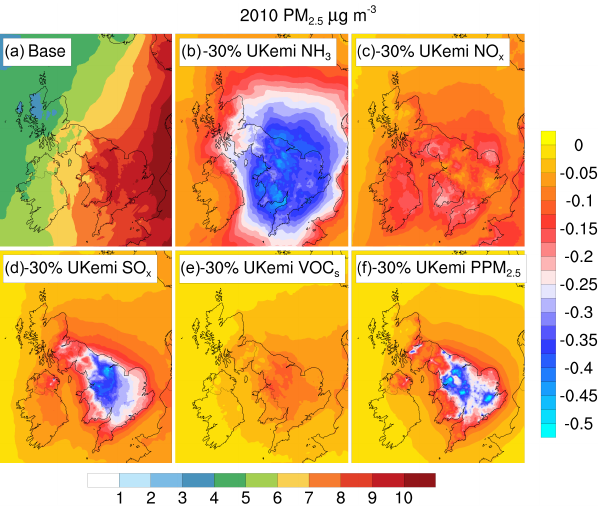
Figure 4. Model simulations of the impact of 30% UK emissions reductions on annual-average surface concentration of PM 2 . 5 . Panel (a) 2010 base-case scenario, no emissions reduction (bottom colour scale); remaining panels, the change in annual-average PM 2 . 5 for 30% UK emissions reductions in (b) NH 3 , (c) NO x , (d) SO x , (e) VOC, and (f) primary PM 2 . 5 (right colour scale). All units areµgm − 3 .